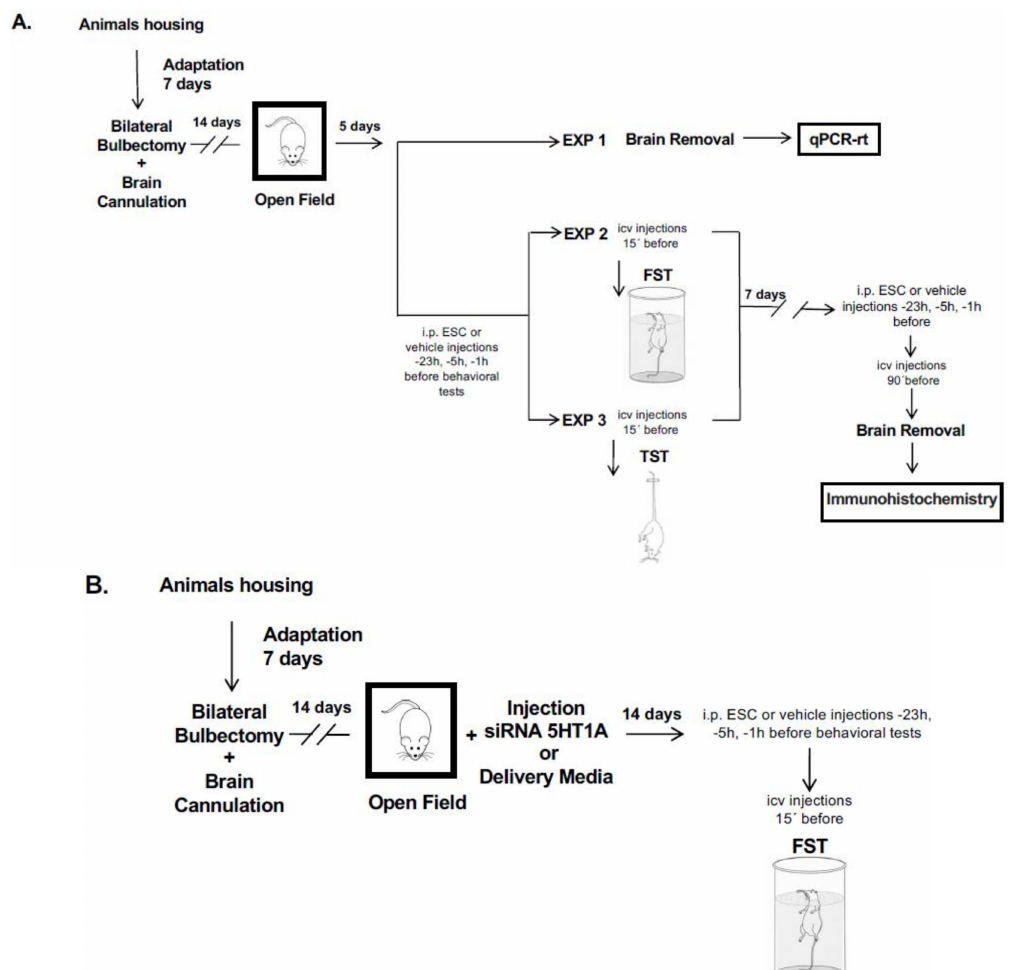
Figure 6. Diagram of the complete experimental schedule. ( A ) After, bilateral olfactory bulbectomy, all animals had a recovery period of 14 days and then we determine their hyperactivity using the open field test (OFT). One set of animals were randomly selected and their brains were collected to perform the experiments of qPCR-rt. In other set of animals, we evaluated the effects of different pharmacological treatments in the forced swimming test (FST) or tail suspension test (TST). After the behavioural tests we collected the brain of the animals to perform the experiments of immunohistochemistry. ( B ) after bilateral olfactory bulbectomy, all animals had a recovery period of 14 days and then we determine their hyperactivity using the open field test. After we injected siRNA 5HT1A or delivery media and all animals had a recovery period of 14 days and then we evaluated the effects of different pharmacological treatments in the